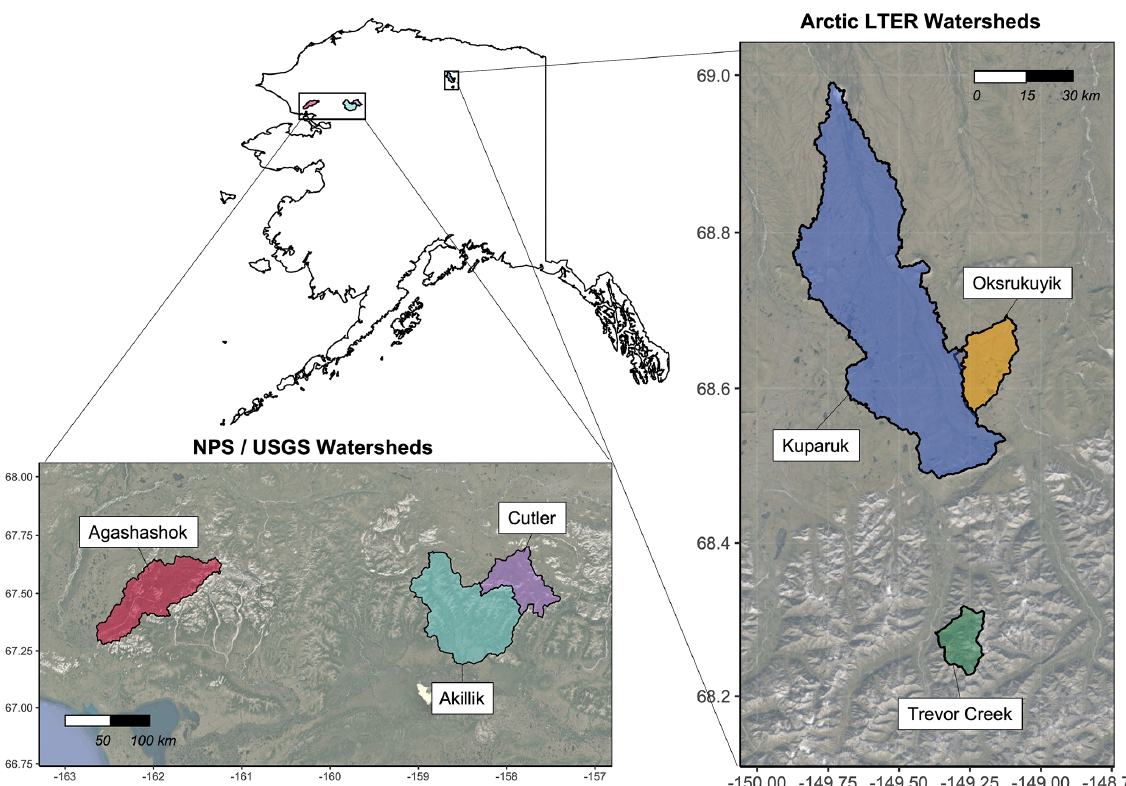
Figure 1. Regions of northern Alaska associated with the Arctic Long-Term Ecological Research site at Toolik Field Station (TFS) and National Park Service (NPS) and U.S. Geological Survey (USGS) watersheds. Map created in R Studio (version 1.2.1335) with base imagery from ESRI and © Google Earth (version